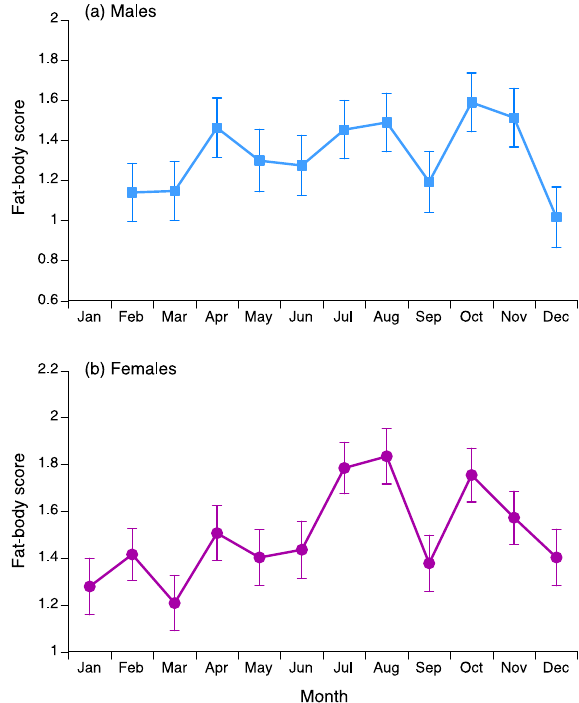
Figure 5. Monthly variation in size of the fat bodies in Asian bockadams ( Cerberus schneiderii ) examined at processing facilities near the city of Cirebon in West Java. The upper panel ( a ) shows values for males, and the lower panel ( b ) shows values for females. Points show mean values and associated standard errors for each month. Note that fat-body size was scored on a 4-point scale (0–3) but is treated as a continuous variable here to show patterns.